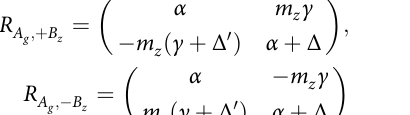
ð Þ = I A 5 = B 3 2 g